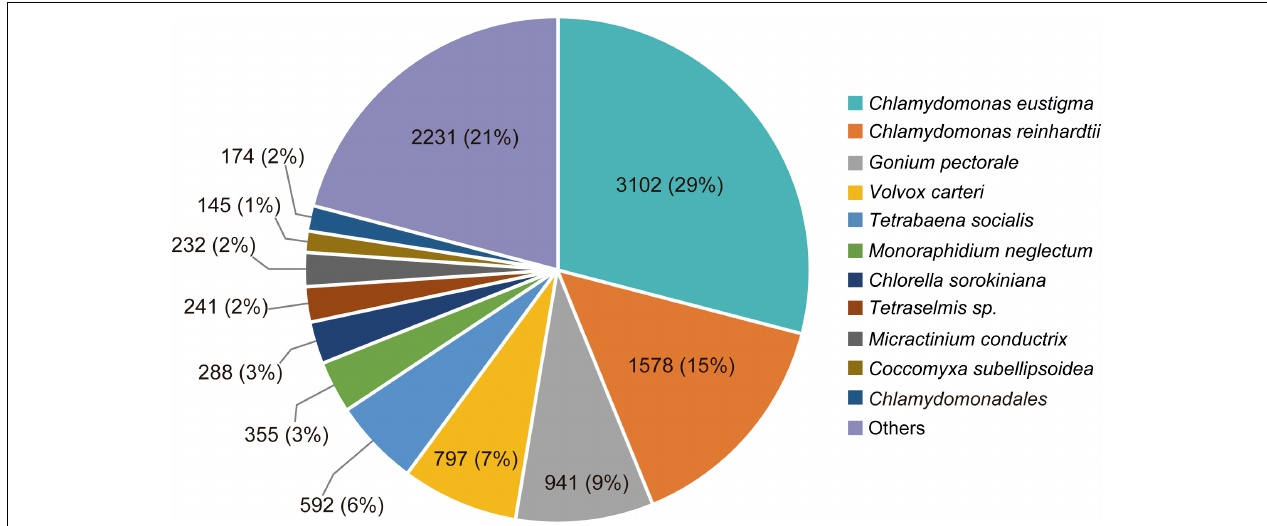
FIGURE 8 | Species distribution of the top BLAST hits by NR database annotation for Chlorominima collina CCAP 6/1. Percentage distribution of the 10 most successful species identified for each BLAST-assembled sequence against the NCBI non-redundant protein database. In addition to the percentage value, the number of genes noted per species is indicated.